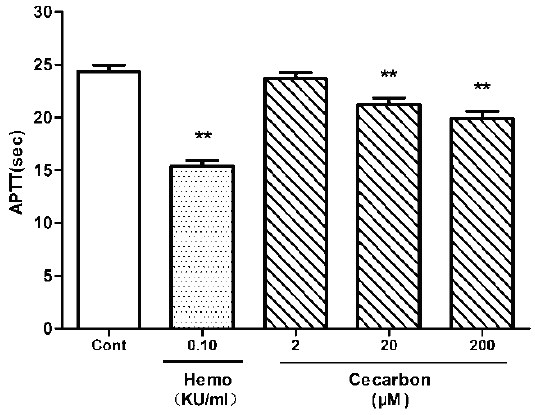
Figure 5. Effect of cecarbon on New Zealand rabbit plasma APTT. Data were expressed as mean ± SD ( n = 6) and p -values were calculated using non-parametric repeated measures ANOVA (Friedman test) (** p < 0.01).